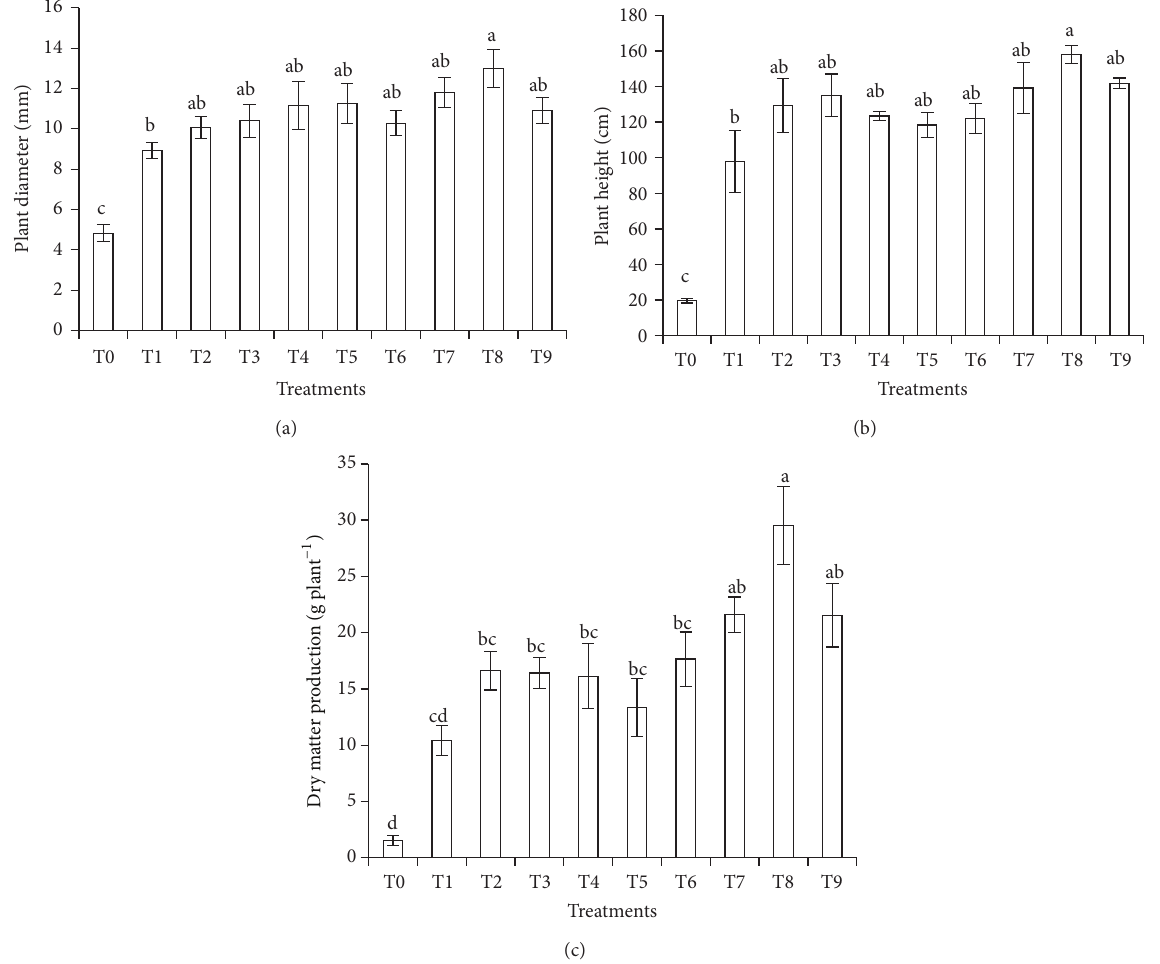
Figure 4: Effect of treatments on diameter, height, and total dry matter production of maize plant at 48 DAS. Different alphabets indicate significant difference between means using Tukey’s test at 𝑃 ≤ 0.05